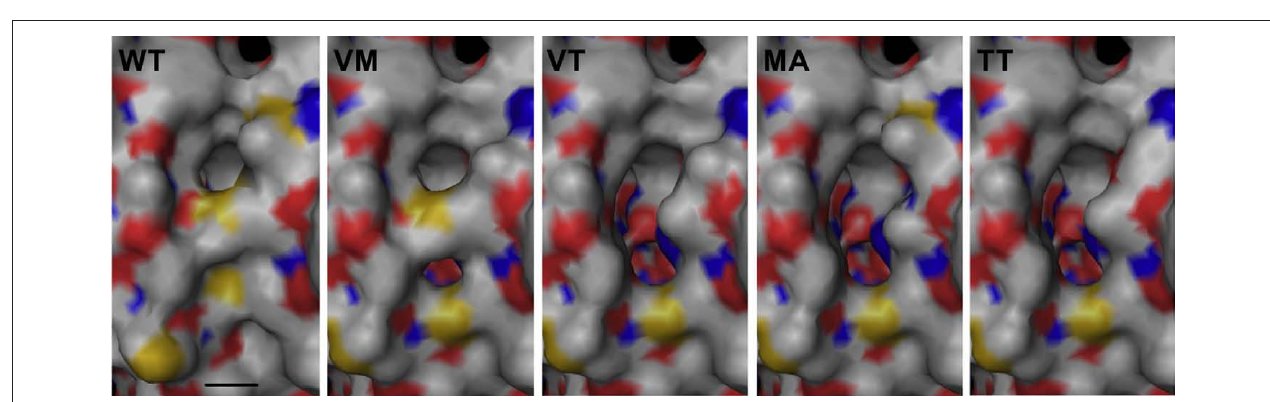
FiguRe 4 | histogram of relative activities of wild type SOR and mutants, the wild type was set to 100% according to the values in Table 3.